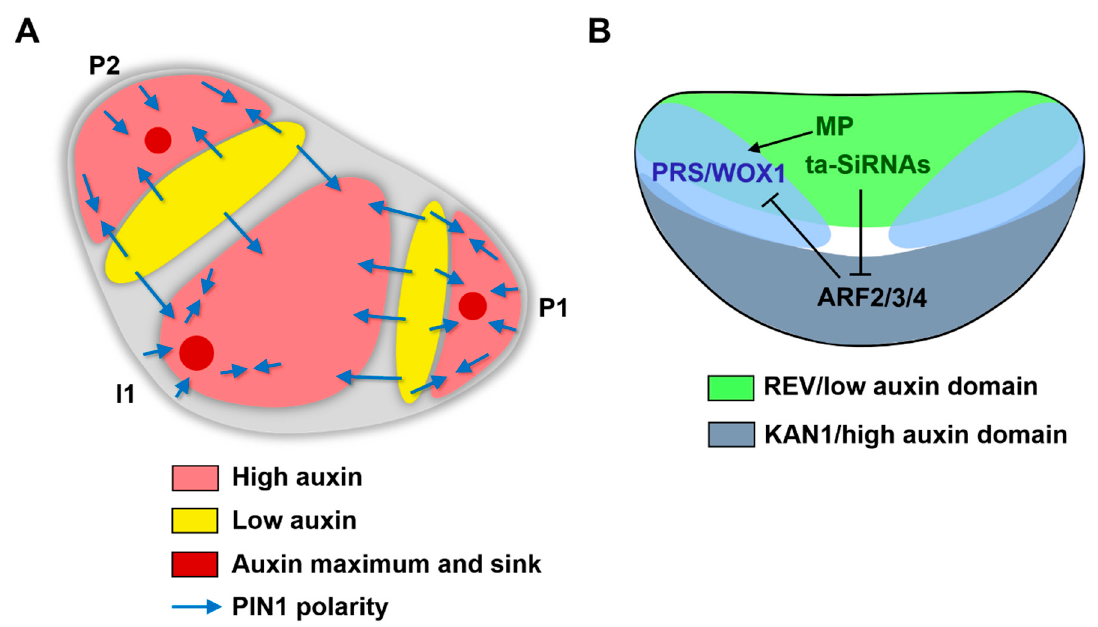
Figure 2. Models of the regulation of leaf initiation and early patterning by auxin. ( A ) Model of the regulation of leaf patterning by auxin polar transport in the epidermis and spatial auxin distribution. Note that auxin maxima are also auxin sinks, where PIN1 directs auxin transport into inner cells. Modified from [20,21]; ( B ) Model of the regulation of leaf patterning by spatial auxin distribution and signaling. Modified from